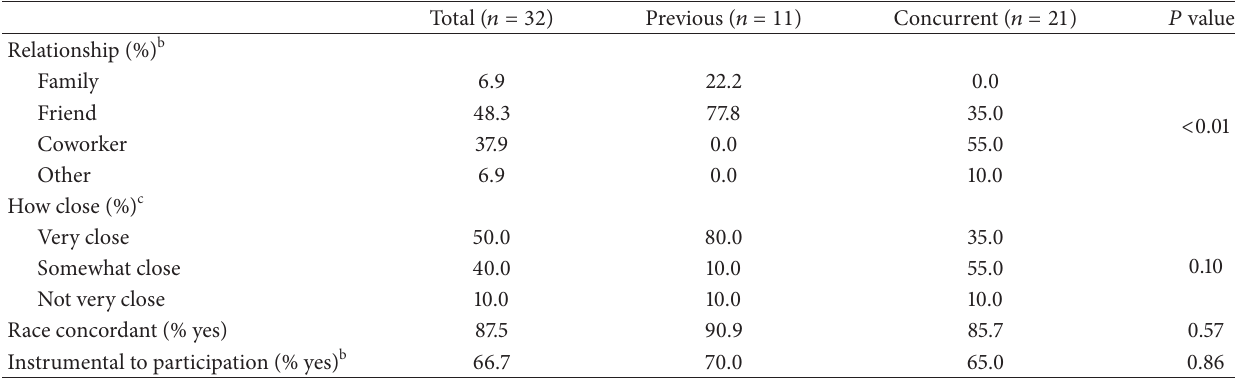
Table 3: Nature of contact for those with a single social contact ( 𝑛 = 32